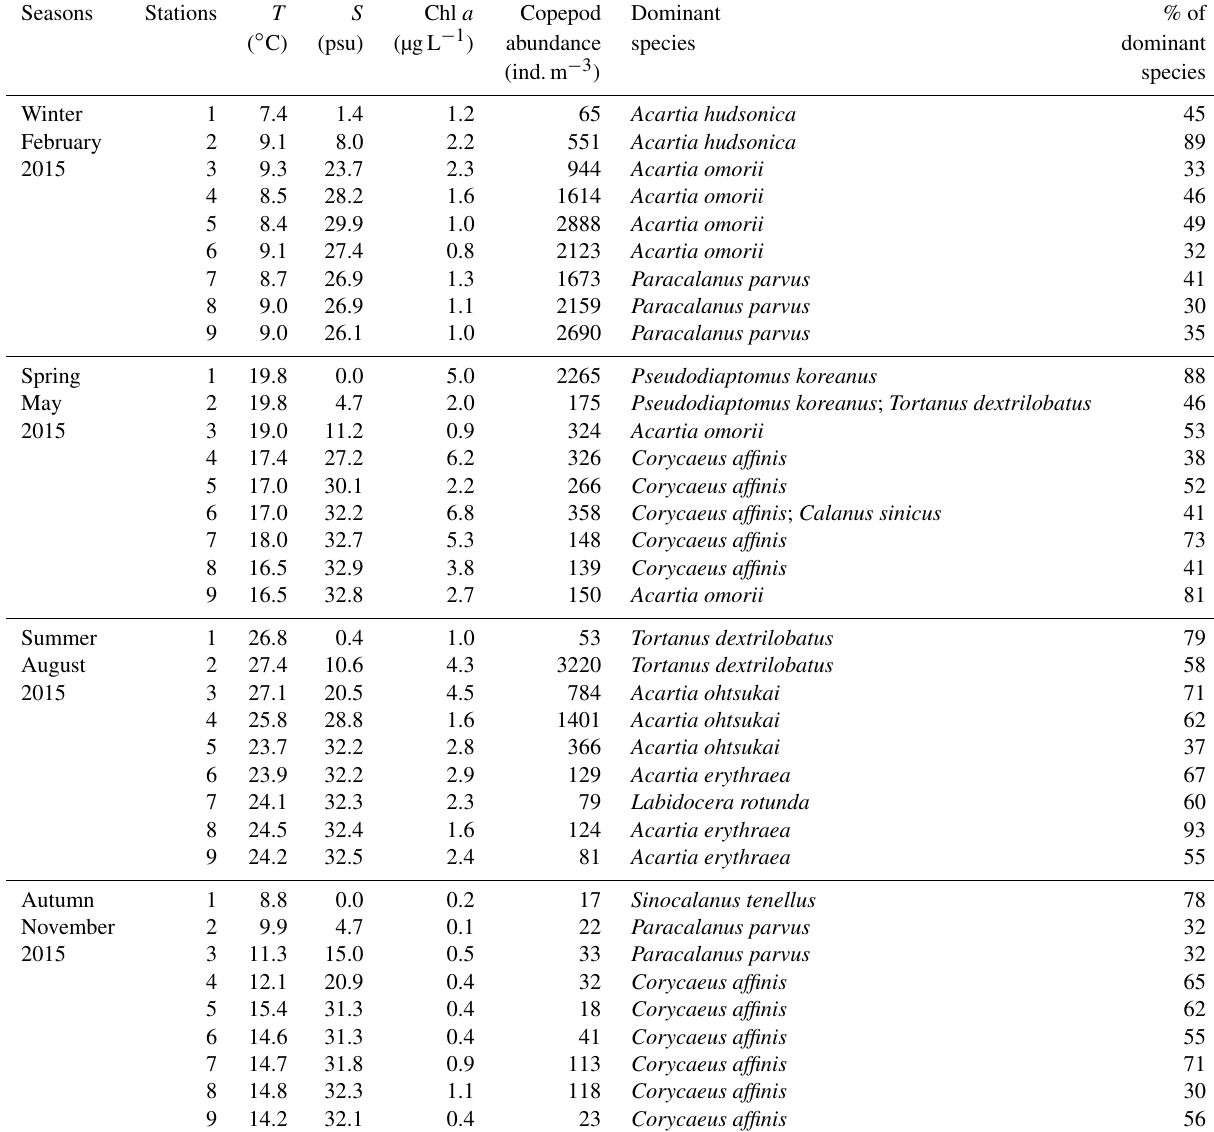
Table 1. Seasonal variations in basic environmental factors, including temperature ( T ), salinity ( S ), and chlorophyll a (Chl a) , copepod abundance, and dominant species and the percentage (%) of dominant species in total copepods at the nine stations in the Gwangyang Bay